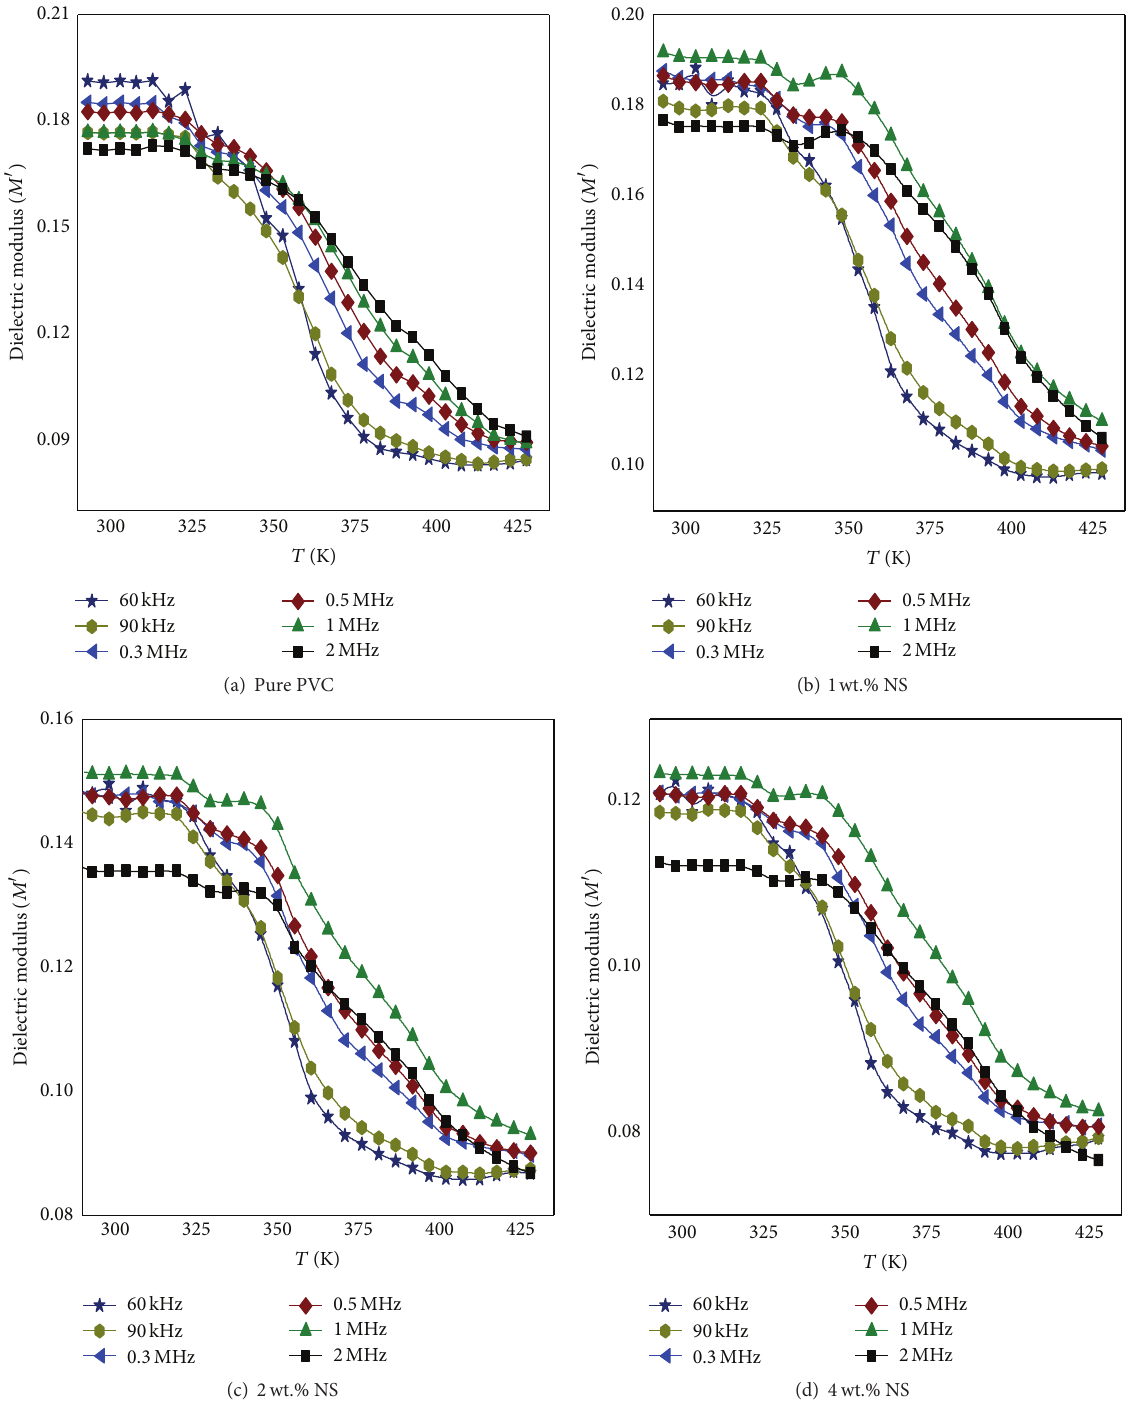
Figure 10: The variation of dielectric modulus 𝑀 󸀠 as a function of temperature at some fixed frequencies for pure PVC and PVC-SiO 2 nanocomposite